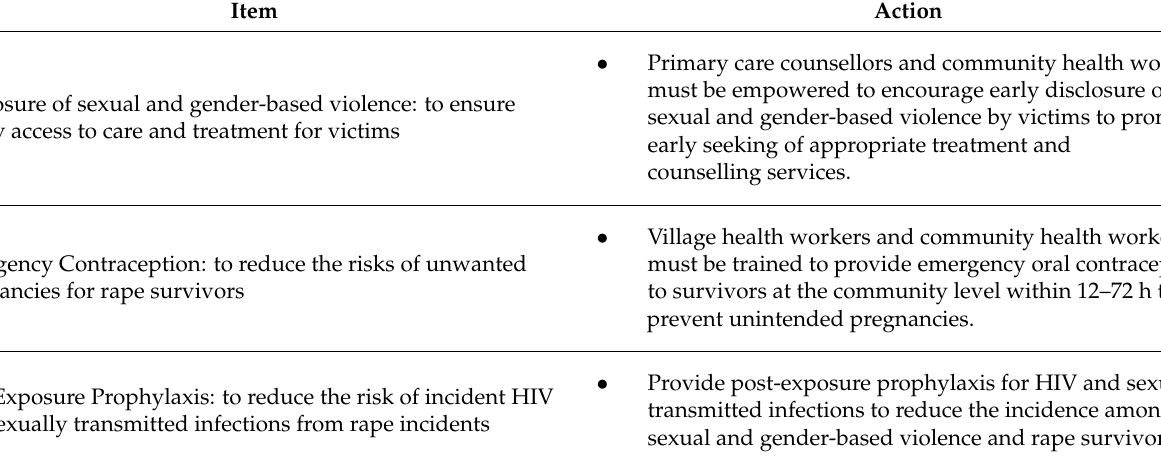
Table 4. Ensuring early care for sexual and gender-based violence and rape survivors at the commu- nity